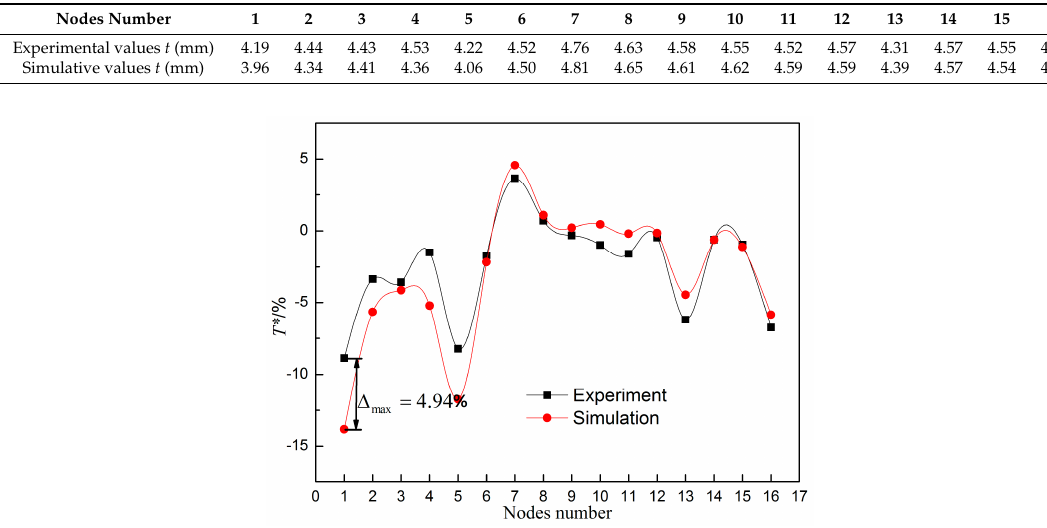
Figure 7. Distributions of experimental and simulative T * along the selected path.